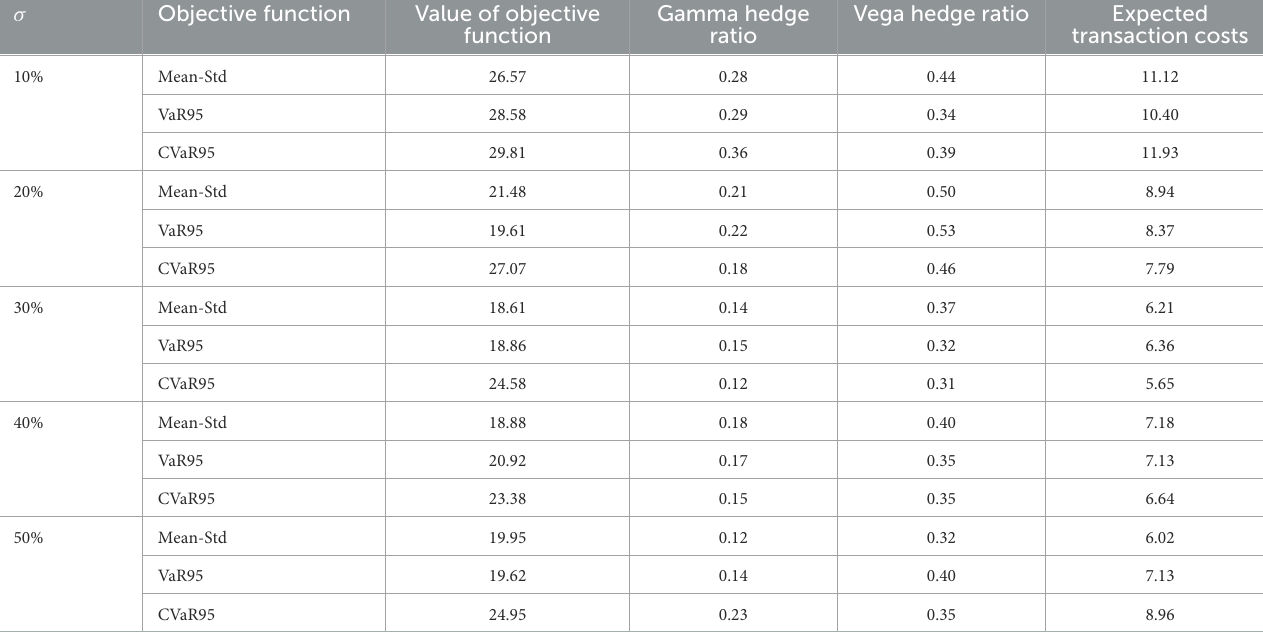
TABLE 5 Values of the objective function when the hedging strategy is developed with values of the initial volatility, σ , that are different from the actual 30% value. σ Objective